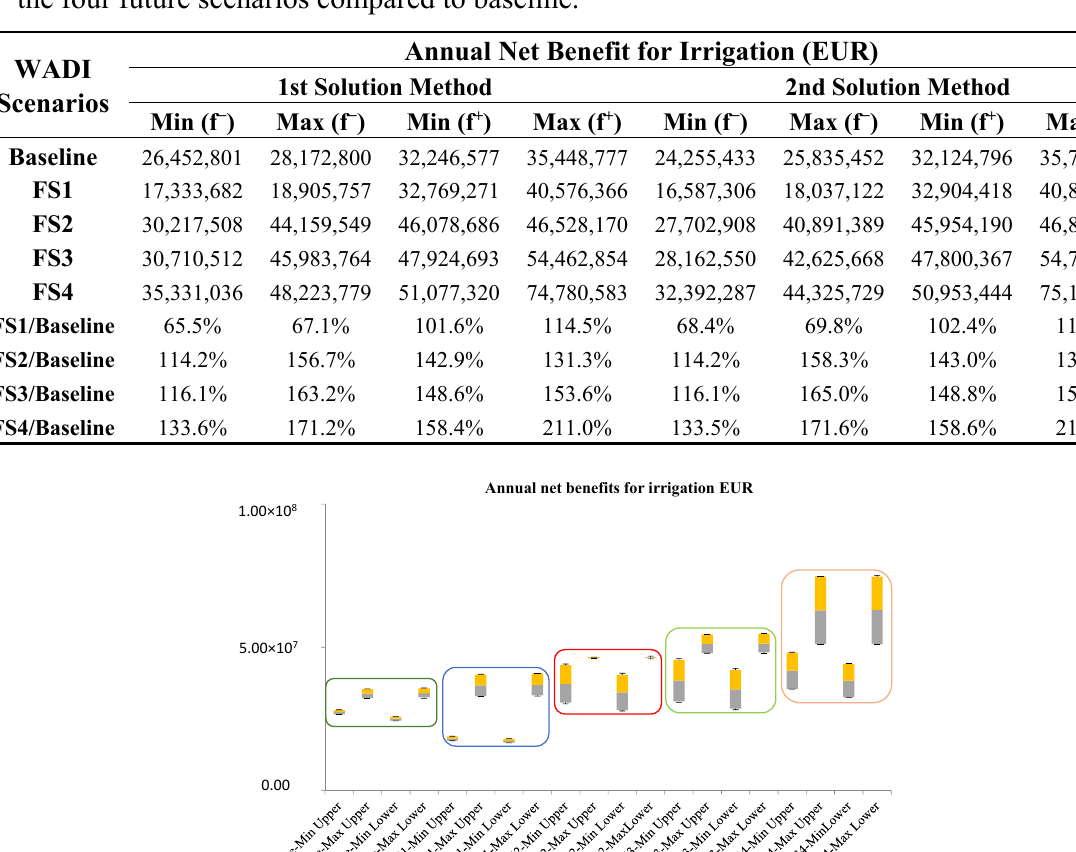
Figure 4. Box plots for the four options of total net optimized benefits in EUR for the baseline and the four future scenarios (FS1: Future Scenario 1; FS2: Future Scenario 2; FS3: Future Scenario 3; FS4: Future Scenario 4). Table 24. Annual net benefit (EUR) for irrigation and ratios (%) of annual net benefit of the four future scenarios compared to baseline.